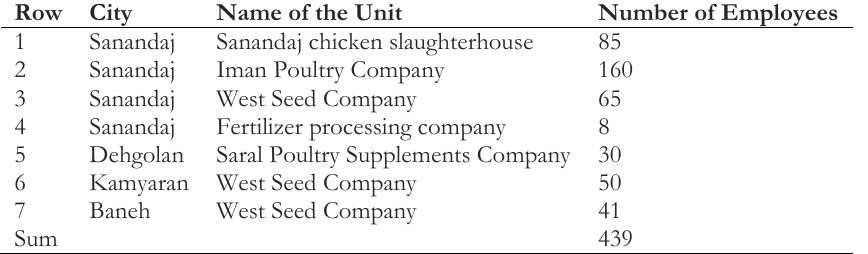
Table 2. Number of companies in the research statistical